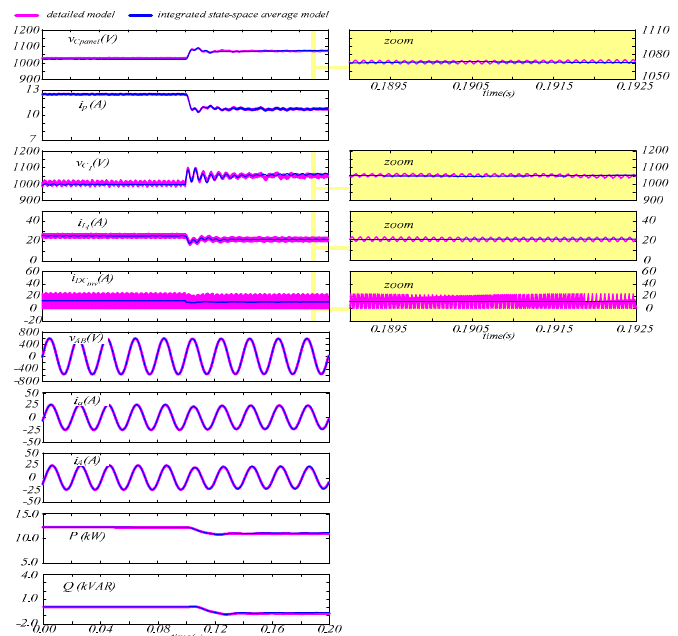
Figure 9. Simulation of a 18.9 kW PV subfield (2 strings in parallel, each string is composed by the series connection of 30 315 W PV modules). PV system topology is represented in Figure 5, technical data of components are listed in Table 2. Irradiance is 1000 W/m 2 , module temperature is 25 °C. Comparison between detailed model and integrated state-space average model.